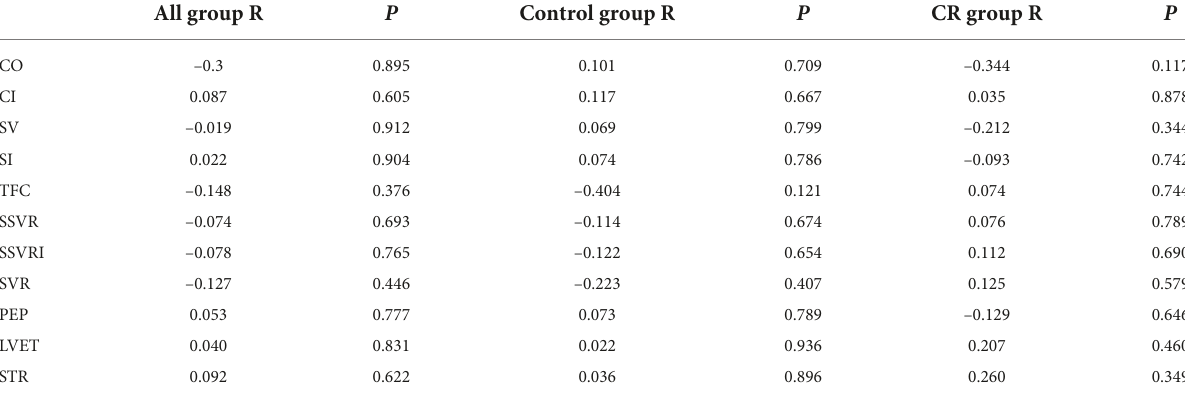
TABLE 9 Correlation between change of hemodynamic parameters measured by impedance cardiology and change of NT-proBNP in patients with CHD and AHF. All group R P Control group